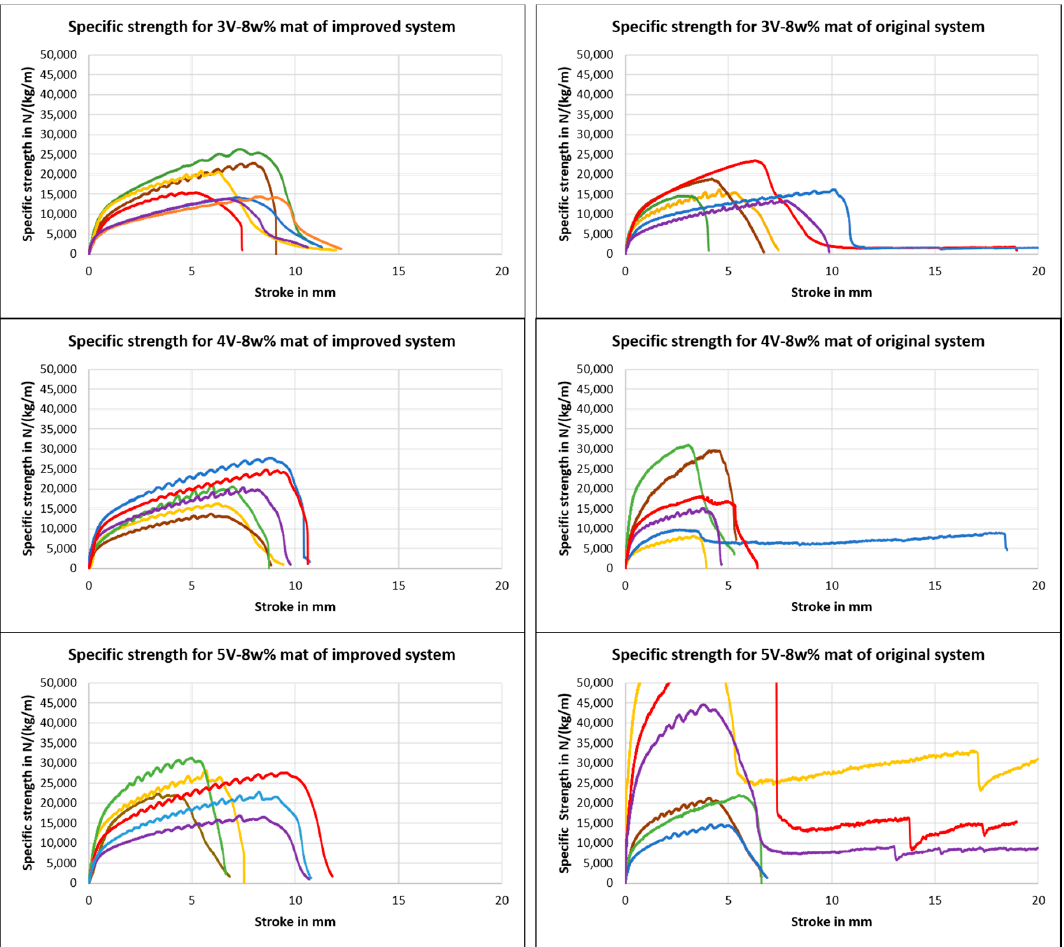
Figure 14. Tensile strengths of nanofiber mats of the improved ( left ) and original systems ( right ). Green, yellow, and brown colors indicate specimens from same mat, and red, blue, and violet colors indicate specimens from another mat of the same configuration.